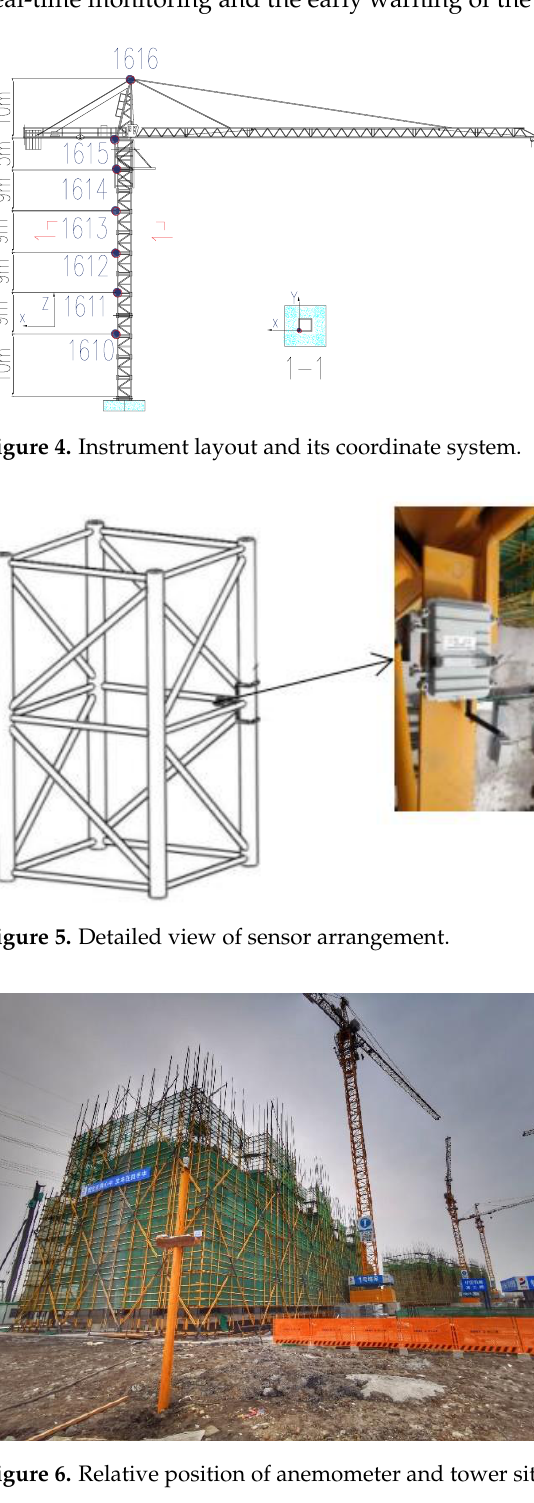
Figure 6. Relative position of anemometer and tower site (Image by Qiang Li). 2.3. IoT Monitoring Cloud Platform Construction Figure 7 shows the topology of the tower crane IoT system built in this study. A com- plete wireless sensor network should include a perceptual layer for data collection, a